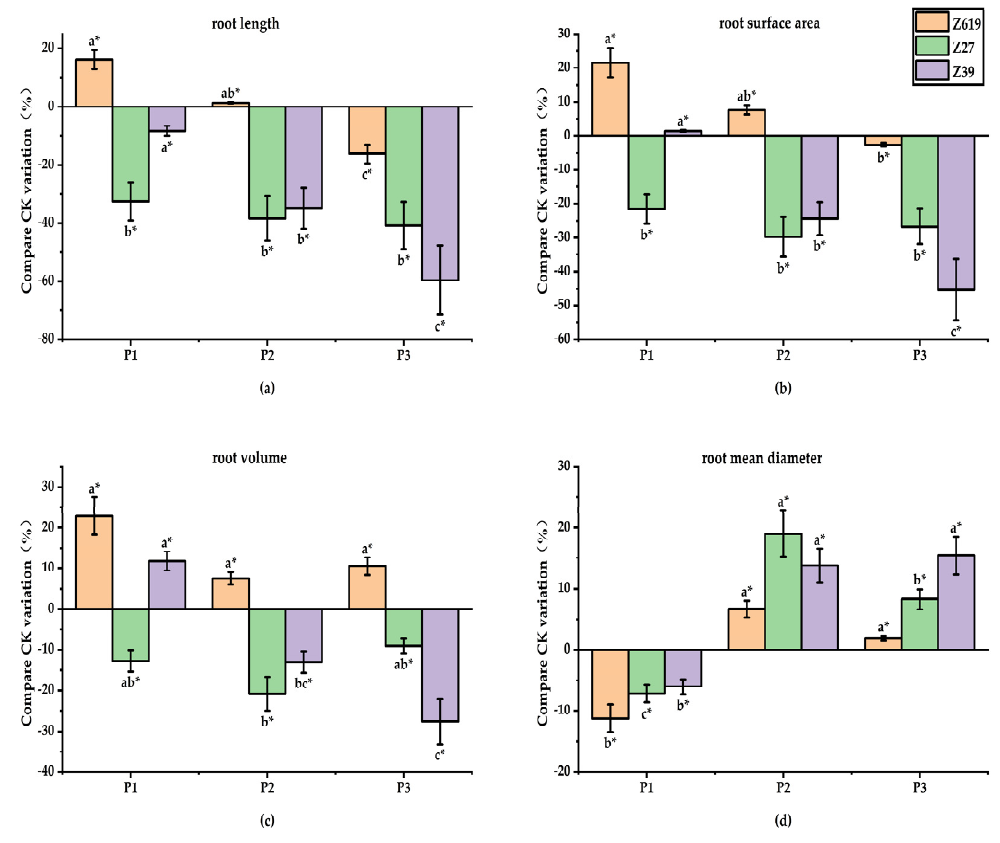
Figure 3. ( a ) Effects of different concentrations of paclobutrazol on root length; ( b ) Effects of different concentrations of paclobutrazol on root surface area; ( c ) Effects of different concentrations of paclobutrazol on root volume; ( d ) Effect of different concentrations of paclobutrazol on root mean diameter. * Different lowercase letters in the figure indicate that different treatments of the same variety have significant differences at p <